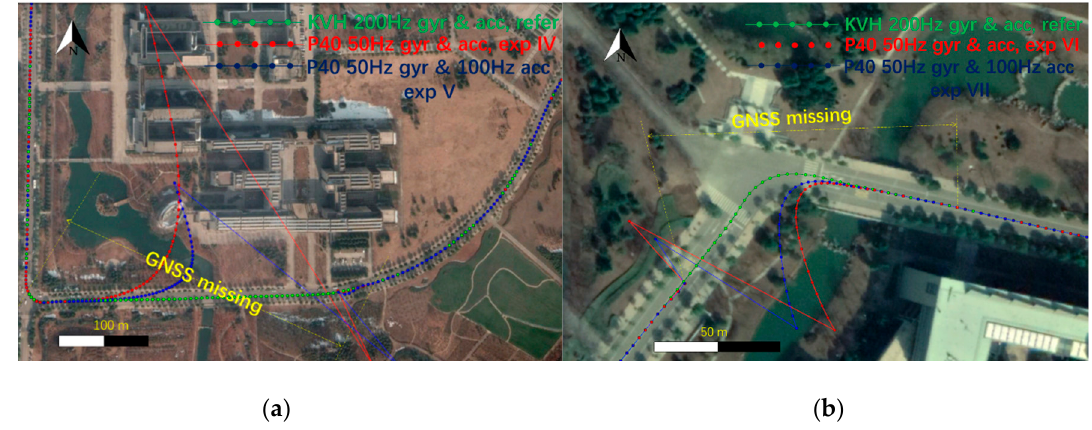
Figure 8. The trajectory of experiments IV to VII projected in Google Earth. The green reference trajectory is from the estimation of GNSS / KVH by the NovAtel IE software, under the GNSS open-sky conditions; the red trajectory is from the estimation of GNSS / IMU-P40 with the 50 Hz gyros and accelerometers by the conventional 15-state Kalman filter, under the GNSS-denied environment; the blue trajectory is from the estimation of GNSS / IMU-P40 with the 50 Hz gyros and 100 Hz accelerometer by our modified Kalman filter, under the GNSS-denied environment. ( a ) The 50 s GNSS observables missing in straight line; ( b ) the 30 s GNSS observables missing in turn trajectory line.